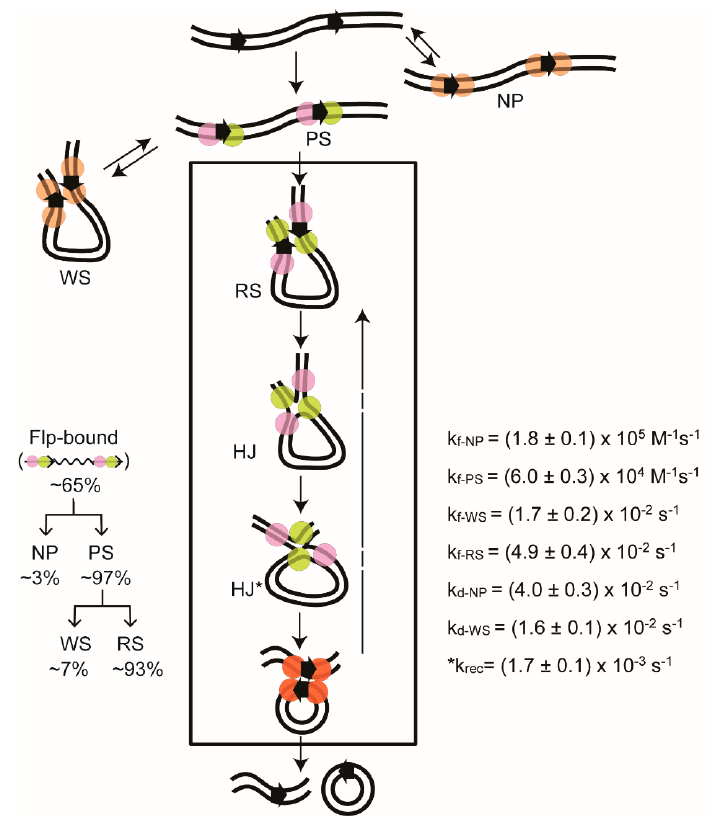
Figure 7. Stepwise view of Flp recombination by TPM. The Flp recombination pathway for the excision reaction using head-to-tail target sites, as inferred from the TPM analysis, is diagrammed. The relative amounts of the individual complexes observed from cumulative single molecule time traces, over a 30 min time course, are indicated. The kinetic constants derived from their life times are listed. The rate constants for the formation and dissociation of a complex is denoted by the subscripts ‘f’ and ‘d’, respectively. The Flp monomers within the recombination synapse are color-coded (pale green or magenta) as in Figure 3 to distinguish between the ‘active’ and ‘inactive’ pairs. All monomers within the product synapse are colored the same, but differently (orange) from those within the recombination synapse, to suggest that the product synapse may have to be reconfigured for initiating the reverse reaction. Similarly, the Flp monomers in the bound complexes that are not in the functional reaction path are shaded in pale orange. The chemical reversibility of the reaction is indicated by the long upward arrow. Rather unexpectedly, our experiments reveal completion of recombination by nearly all of the synapsed molecules. Few Holliday junction molecules are detected. NP = Nonproductive complexes; PS = Pre-synaptic complexes; RS = Recombinogenic synaptic complexes; WS = Wayward synaptic complexes; HJ, HJ* = Holliday junction isomers. The thermodynamic and kinetic features are similar for the inversion reaction from the substrate with head-to-head target sites. The rate constant for completion of recombination in the RS-complexes, k rec , is marked by an asterisk to indicate that it was derived from the inversion reaction.